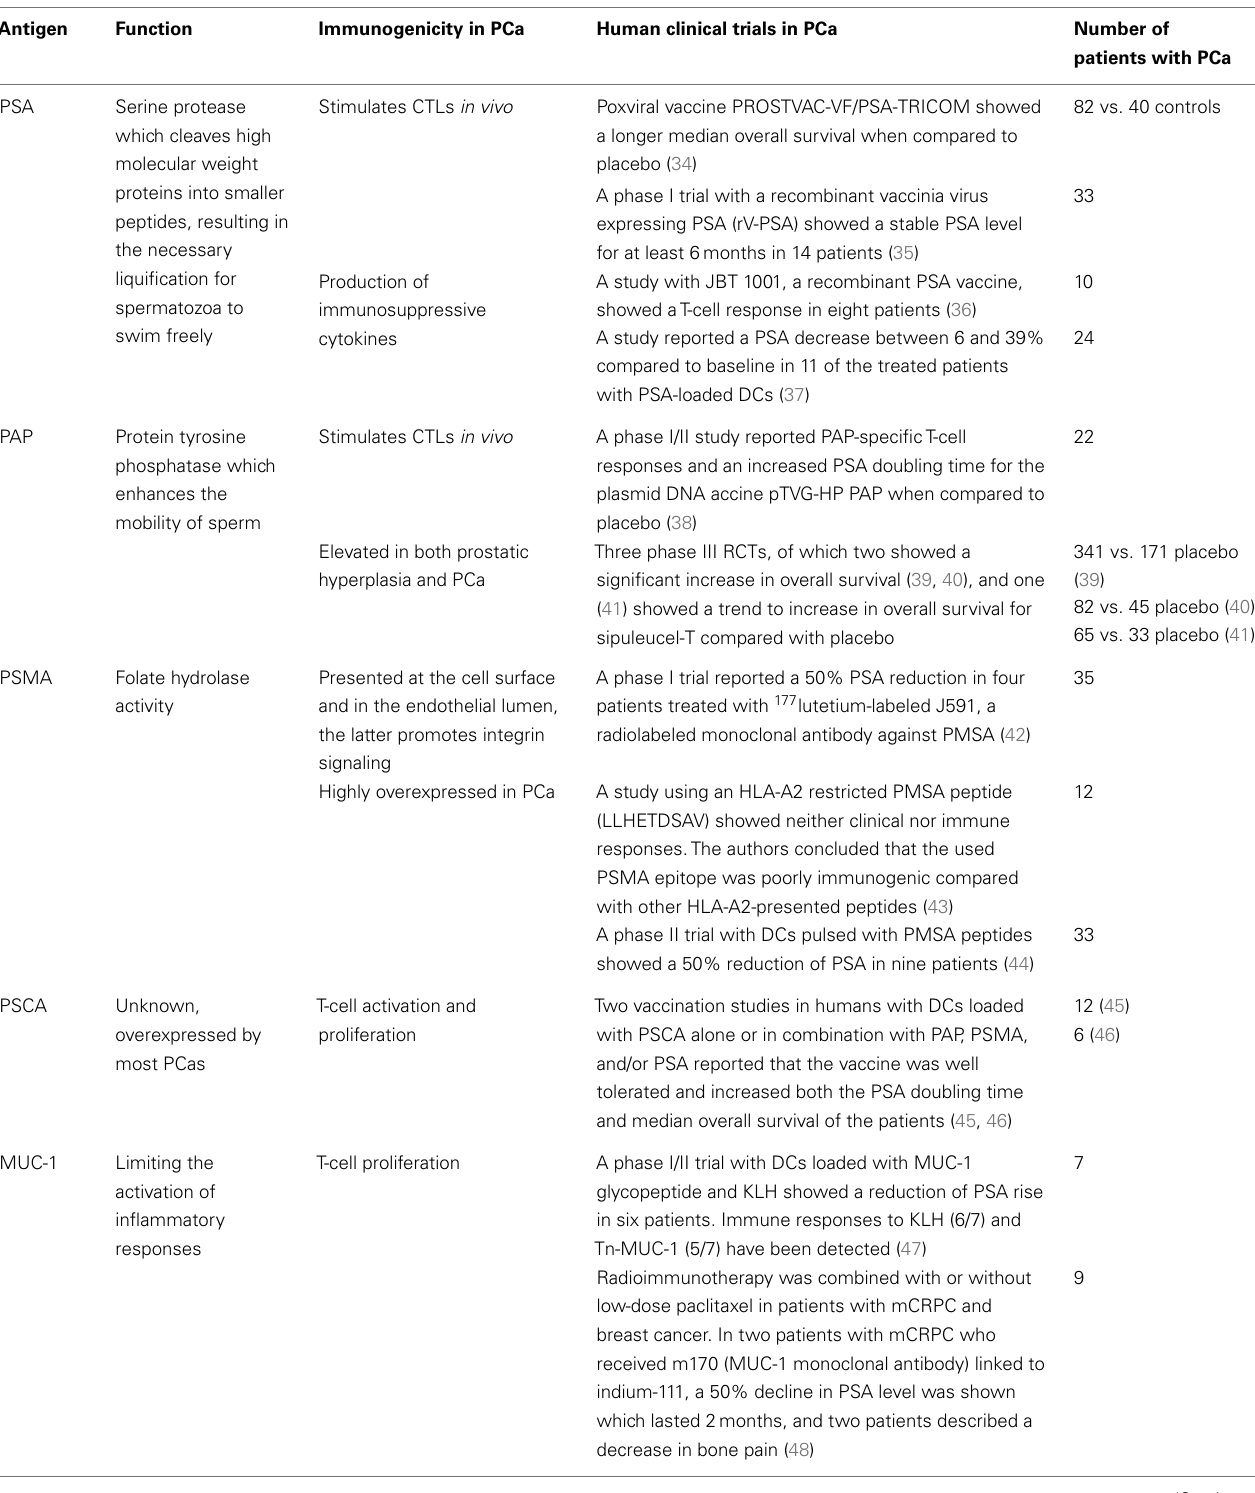
Table 1 |Antigens and their immunogenicity in prostate cancer